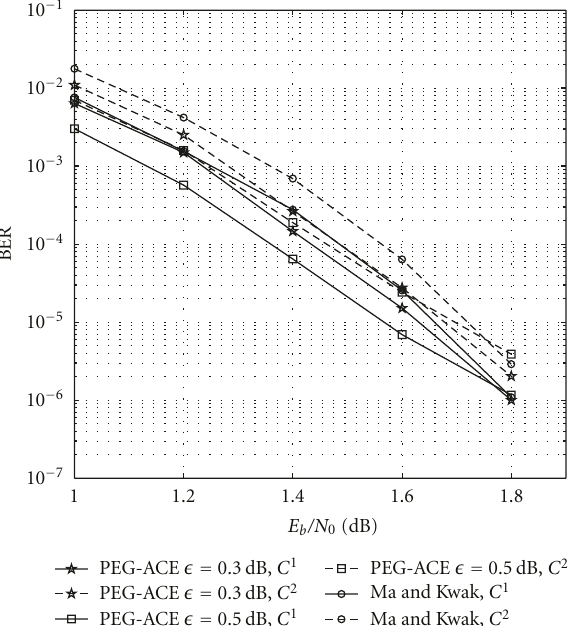
Figure 6: BER performance of two PEG-ACE codes and the code designed by Ma and Kwak [6] after 100 decoder iterations. Both codes have n = 2048 and d v max = 20. The PEG-ACE (cid:2) = 0 . 3 dB code performs slightly better than the code designed by Ma and Kwak for both classes. The PEG-ACE (cid:2) = 0 . 5 dB code performs much better than the Ma and Kwak code for low E b /N 0 , but C 2 has slightly higher BER at high E b /N 0 .